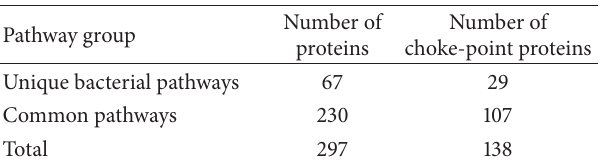
Figure 2: A pie-chart depicting the distribution of the 297 drug targets in Dichelobacter nodosus into the major metabolic pathways. translations (60 proteins) and transport/secretion pathways Table 1: Distribution of the identified 297 putative drug targets into “unique bacteria pathways” and “common pathways.” The number (49 proteins), accounting for approximately 33% of the drug of proteins that are involved in choke-point reactions within each targets. Amino acid metabolism and replication and repair group is also